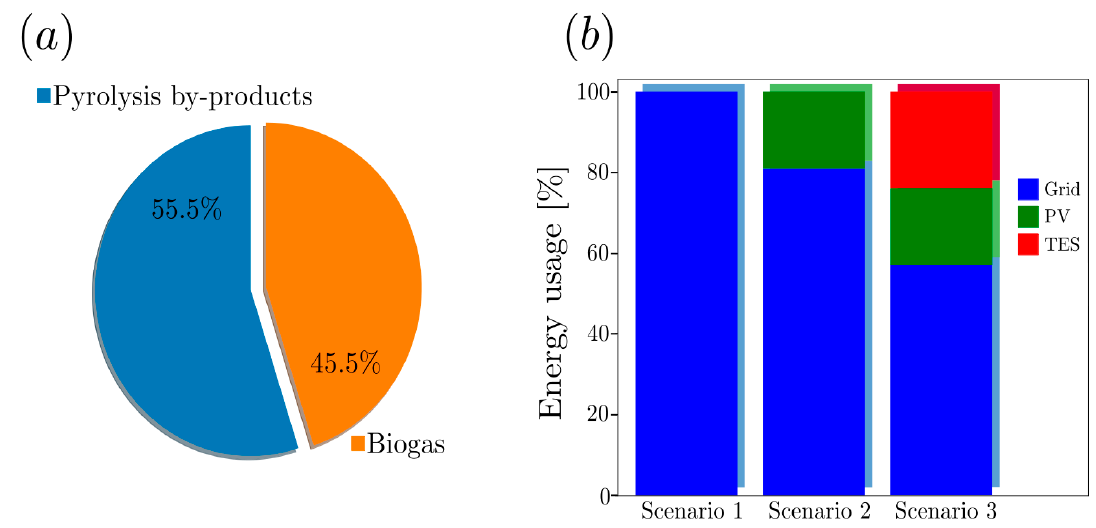
Figure 5. ( a ) Breakdown of the hydrogen contribution by source process; ( b ) Fraction of energy supply by source.